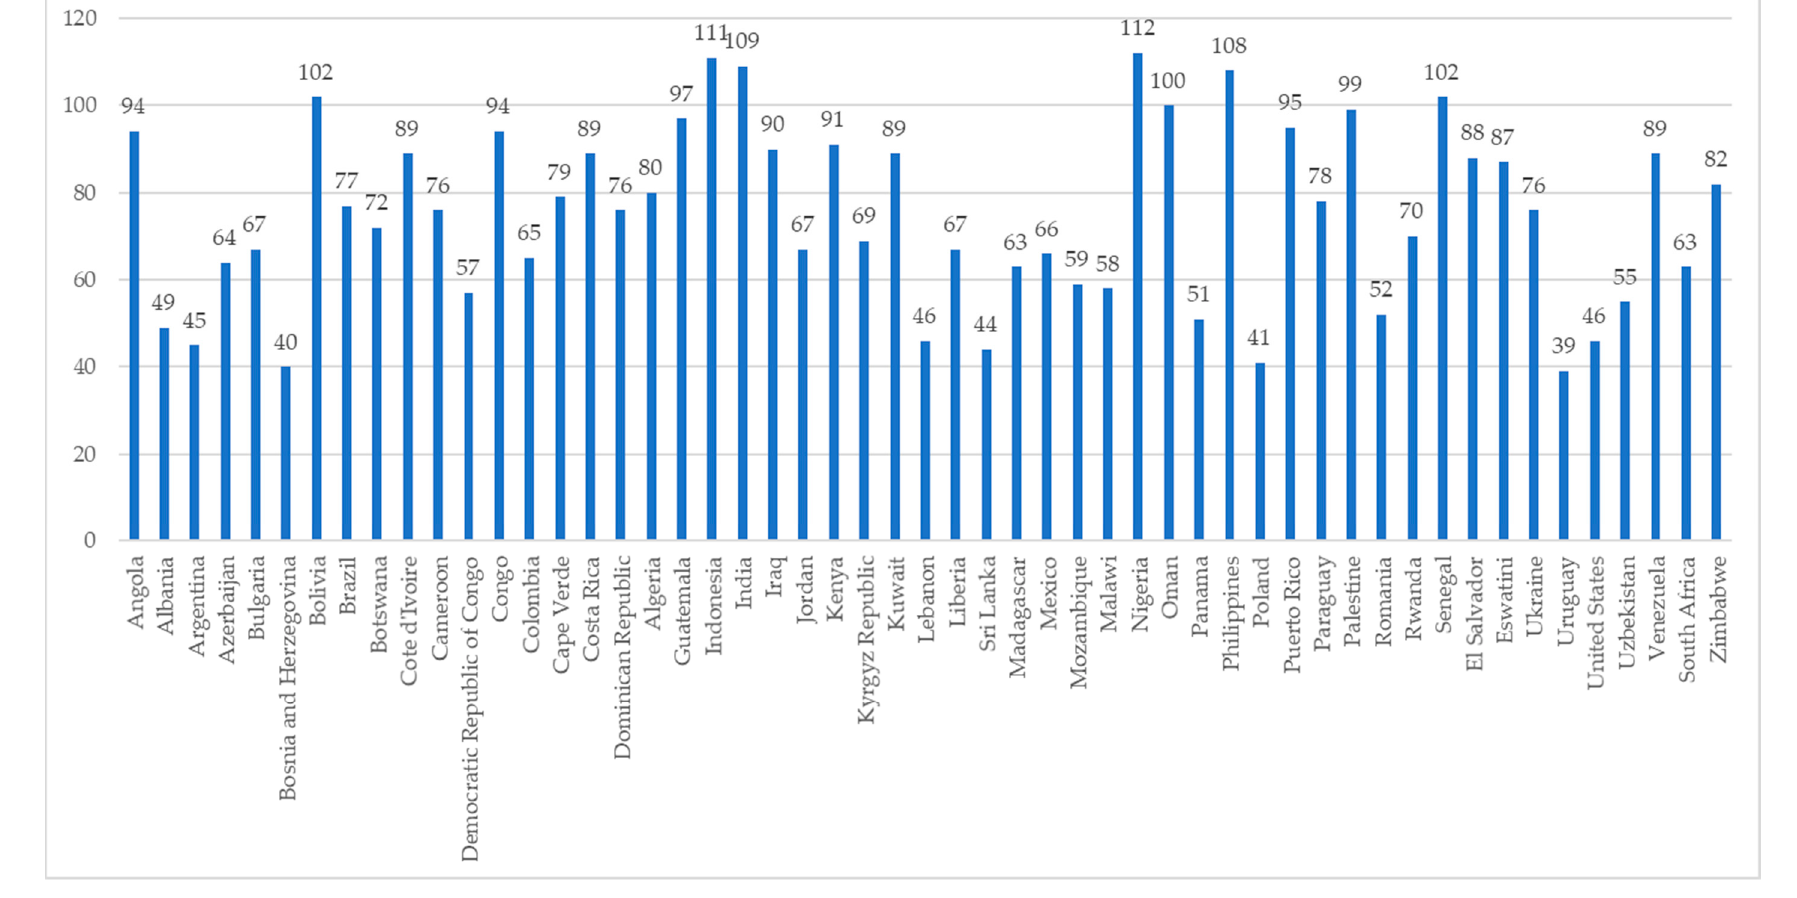
Figure A1. Predicted Peak Times of Non-Peaked